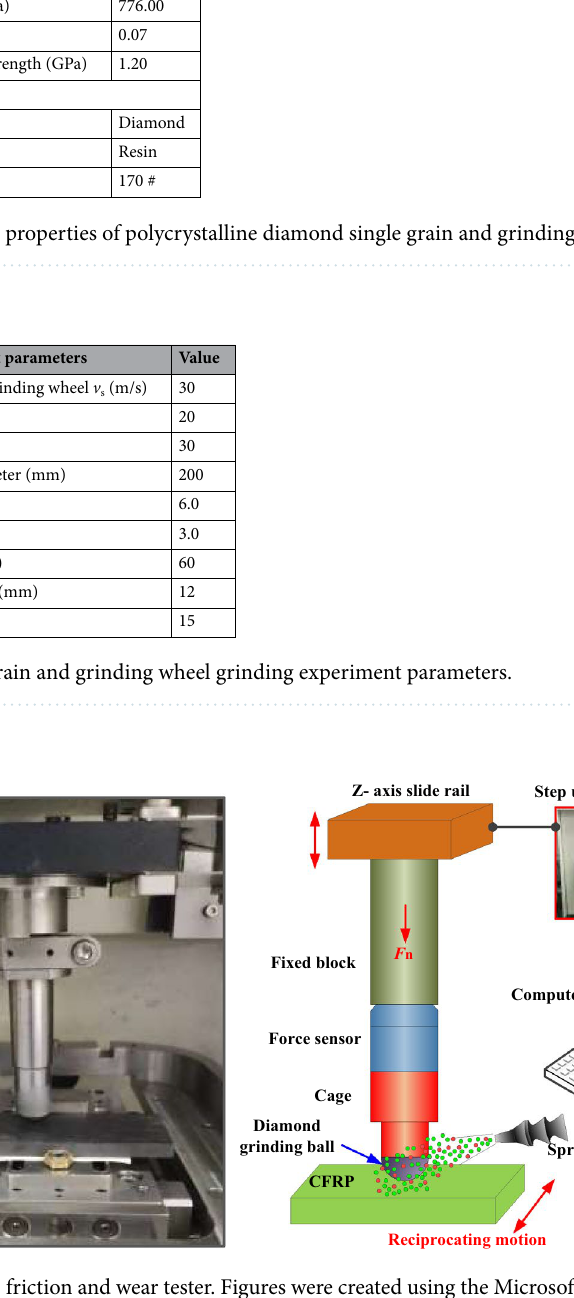
Figure 2. UMT-3 friction and wear tester. Figures were created using the Microsoft Visio sofware (version 2010) and SOLIDWORKS (version